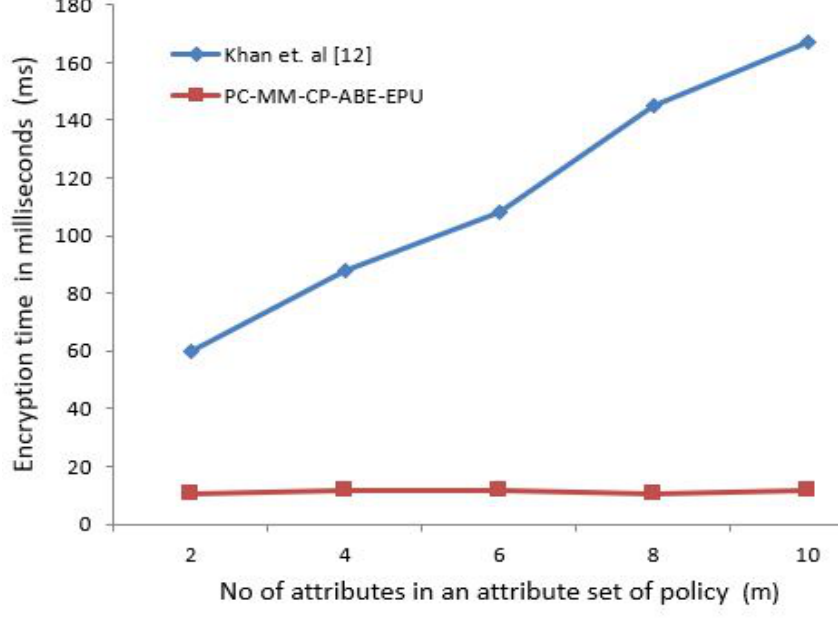
Figure 3. Patient Policy Encryption Time (ms) for # of